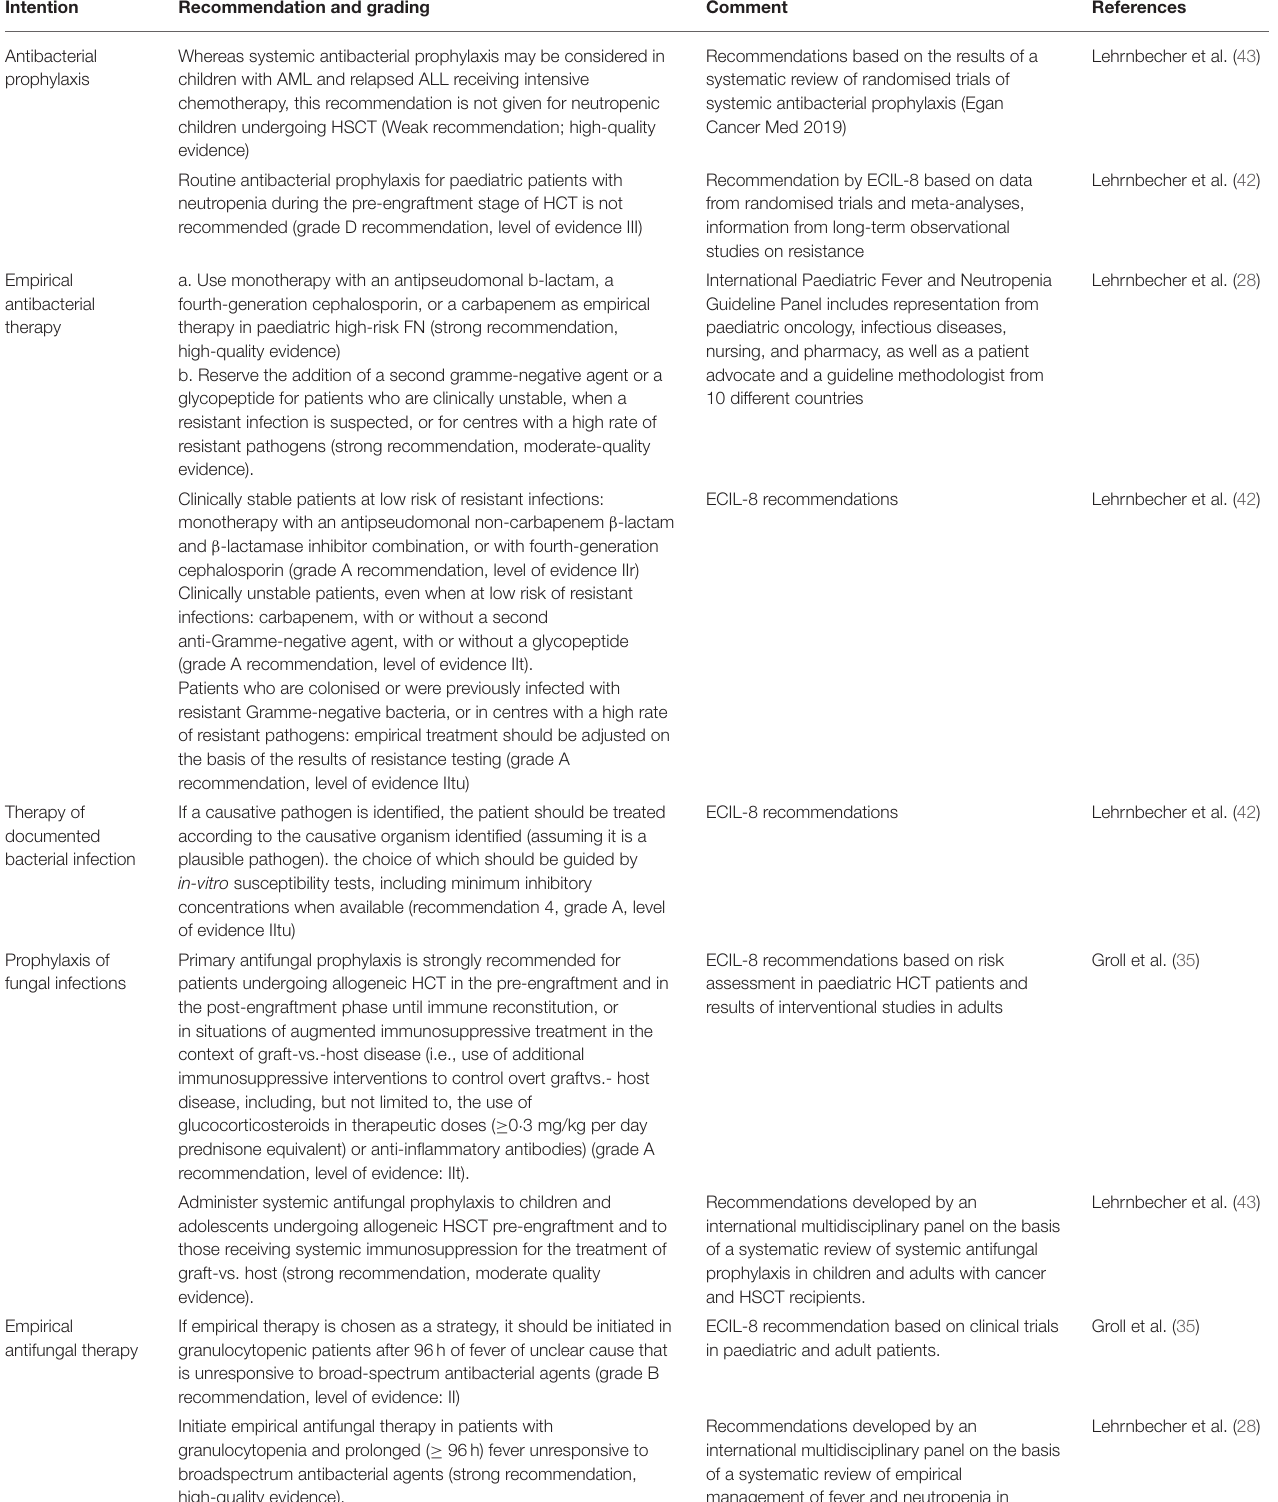
TABLE 1 | Risk factors for bacterial infectious